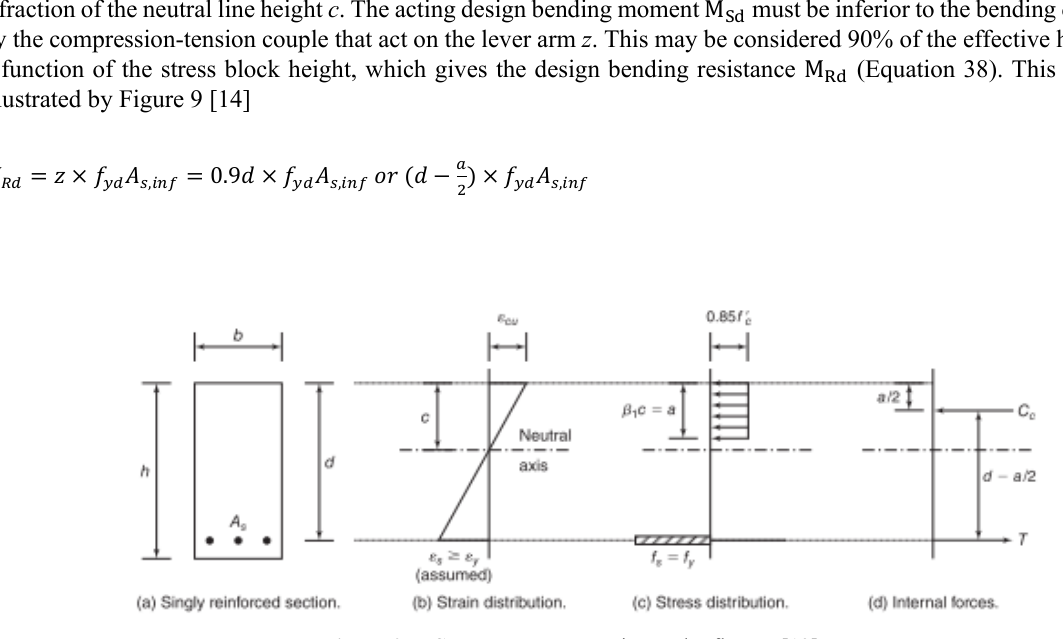
Figure 9: RC concrete cross section under flexure